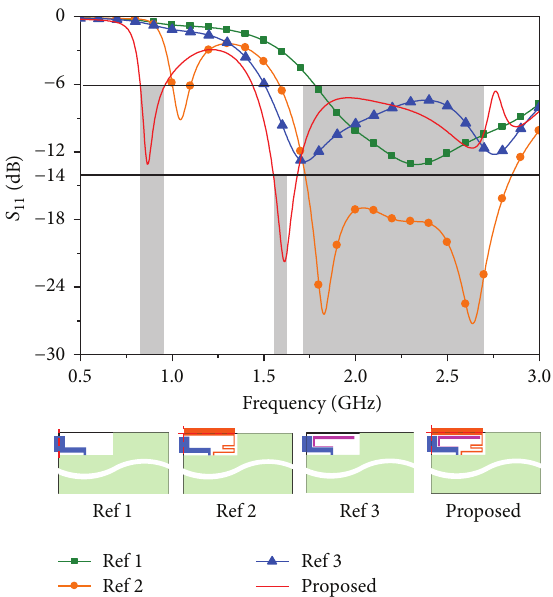
Figure 4: The comparison between the simulated reflection coef- ficient and reflection coefficient of the referenced antennas (Ref 1 contains feeding strip AC; Ref 2 contains feeding strip AC and shorted strip BF; Ref 3 contains feeding strip AC and U-shaped coupling parasitic strip